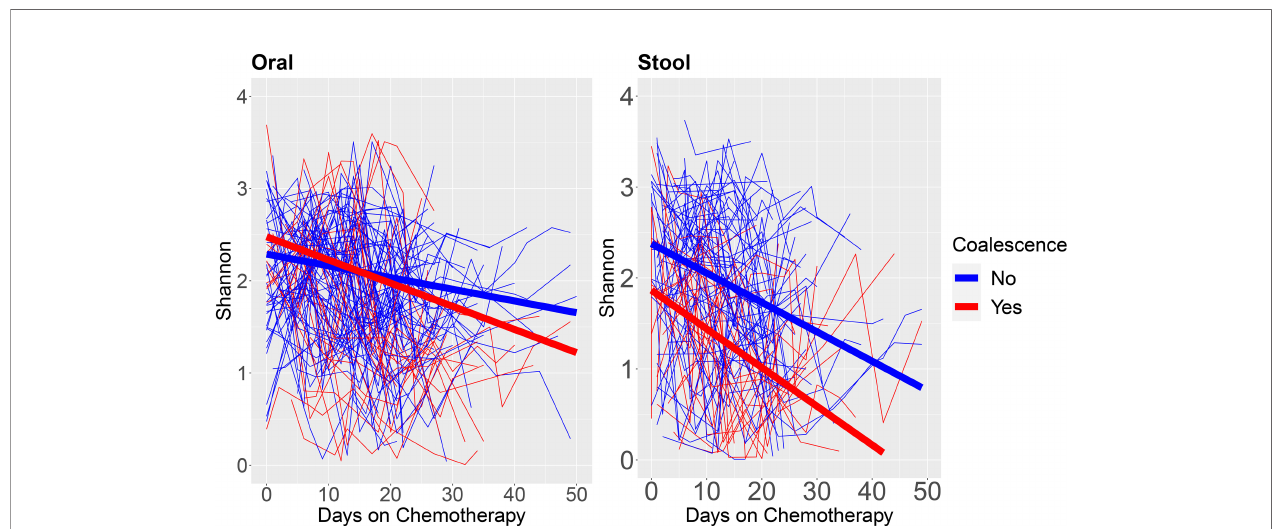
FIGURE 4 | a -diversity over time strati fi ed by patients who do and do not experience oral-stool microbial community coalescence. We fi t linear mixed models on the oral and stool Shannon Diversity by days on chemotherapy to neutrophil recovery for each individual patient. Blue lines are from patients who do not coalesce, whereas red lines are from patients who coalesce. The thick blue line shows the estimated linear trend from the linear mixed model for patients who do not coalesce, and the thick red line shows the estimated linear trend from the linear mixed model for patients who